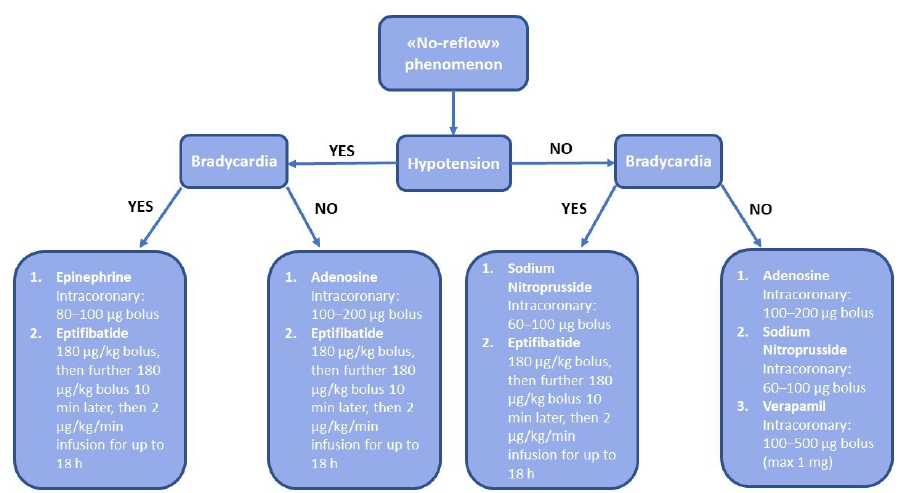
Figure 3. Algorithm of management and treatment of the no-reflow phenomenon applied at our center.